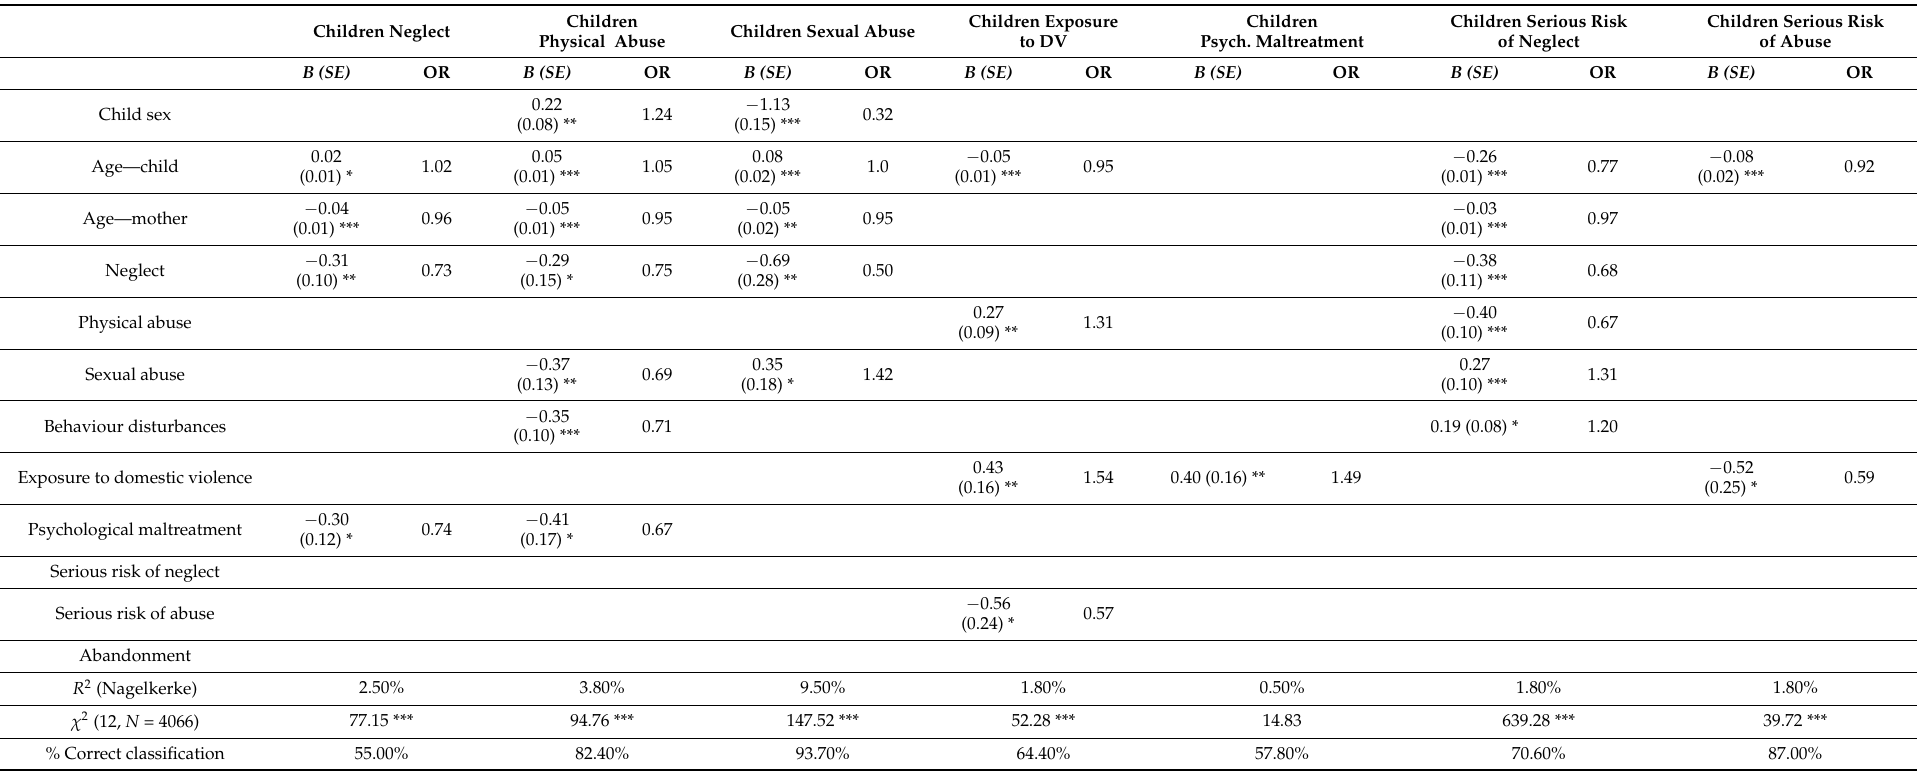
Table 2. Mothers’ child maltreatment histories predicting child maltreatment in